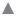
MCsα2 contribute to FDDI, and MCα2 burst firing can reset type A PC spikes.(A) High-frequency stimulation (70 Hz, see arrow) of a presynaptic PC (▲) generates delayed IPSPs on a neighboring PC (▲) via intermediate MCsα2 (О). A mixed excitation (due to a monosynaptic PC–PC connection) followed by a disynaptic inhibition is shown (n = 12 cells, single examples in grey, mean in black). (B) An example of disynaptic inhibition alone (top) is shown (n = 12 cells, single examples in grey, mean in black). Silencing of HaloR-expressing MCsα2 via green light (555 nm) prevents FDDI, although IPSPs are generated following termination of green light stimulation (bottom, n = 12 cells, single examples in grey, mean in black). (C) Mean IPSP amplitudes with (white) and without (green) FDDI at two different time points. (D) Responses from HaloR-expressing MCsα2 (top) and local type A PCs (single-spiking and burst-spiking; middle) and type B PCs (bottom) are shown in presence of carbachol (10 μM). Green light stimulation (500 ms) hyperpolarizes HaloR-expressing MCsα2 and upon termination MCα2 rebound APs are triggered. This burst of APs generates robust inhibition in local postsynaptic type A PCs that synchronizes the timing of PC (rebound) APs. Kernel density estimates (orange) highlight increased (peaks) and decreased (valleys) co-occurance of APs. (E) Example of voltage clamp responses for type A (top) and type B (bottom) PCs in response to MCsα2 burst firing (single examples in grey, mean in black). Values are shown in S4 Data.